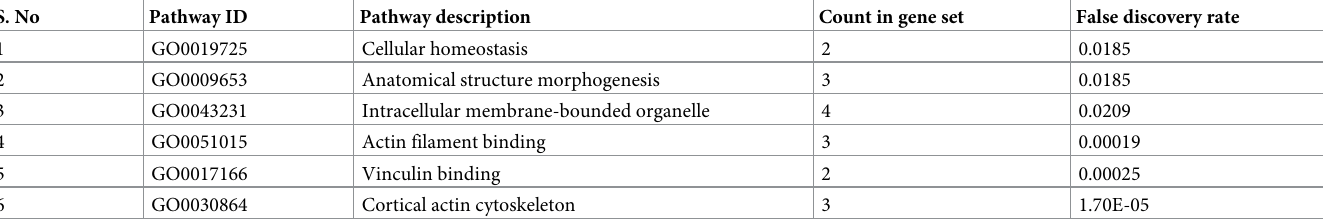
cells alter cellular functions such as cytoskeletal architecture, signal transduction and cell migration for its invasion [47]. WDR1 is an actin interacting protein responsible for actin fila- ment dynamics and cytoskeleton regulation [48,49]. VCL is a cytoskeletal actin binding pro- tein and maintains various physiological processes, such as adhesion and motility by promoting actin polymerization and binding to specific phospholipids [50,51]. ACTN1 is a cytoskeleton actin binding protein and regulates cell-cell matrix adhesion and cell migration [52]. In addition, sodium butyrate also downregulated a vacuolar ATPase proton pump pro- tein ATP6V1A that acidifies intracellular compartments to increase permeability of endo- somes, and results in vesicular swelling, and intracellular bacterial growth [53]. Expression of ATPV1A in macrophages is increased during Salmonella infection and intracellular replication [53,54]. Together, the reduction of these proteins by sodium butyrate might decrease S . Enteri- tidis invasion in the HTC cells. Table 7. Pathways downregulated by sodium butyrate treatment in S . Enteritidis infected HTC cells. S. No Pathway ID Pathway description Count in gene set False discovery